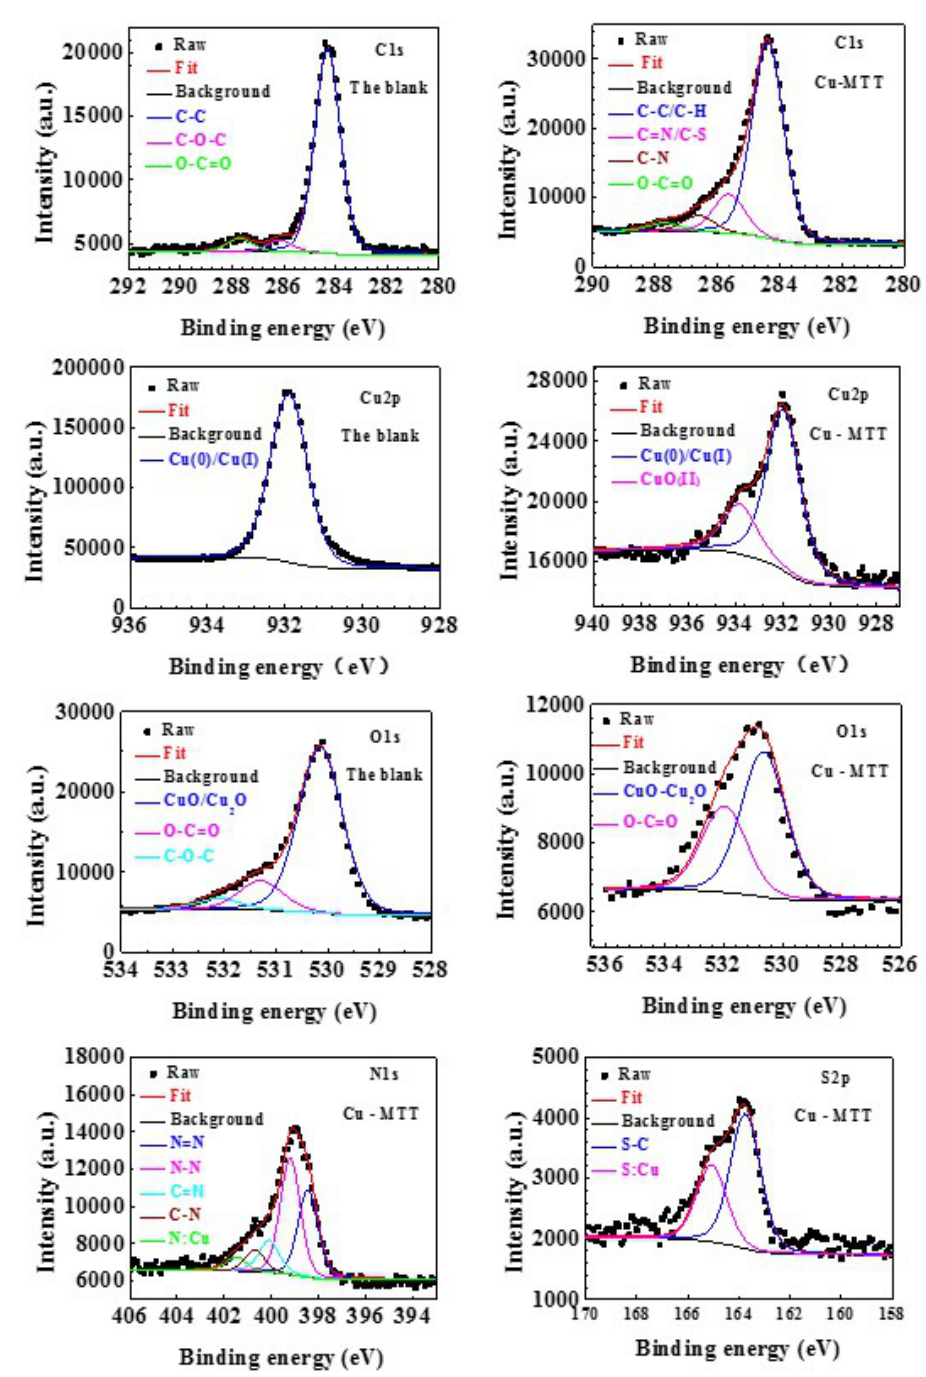
Figure 9. The de-convolution XPS spectra of for the blank and Cu-MTT film, respectively.